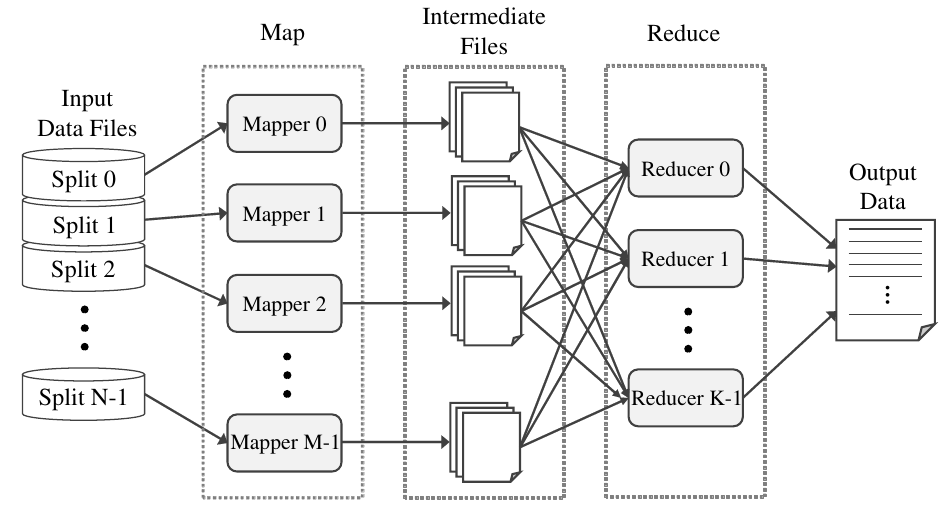
Figure 7. Logical data flow in a MapReduce program.